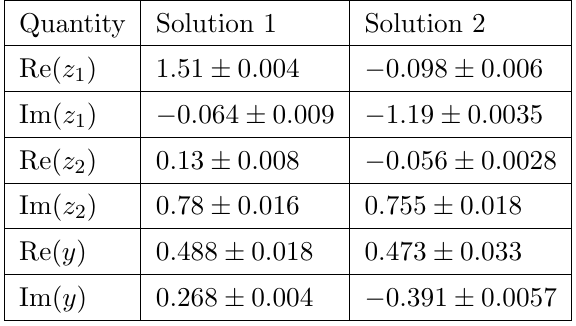
Table 2 . The values of the complex parameters z 1 , z 2 , and y for the two solutions for Case II. can be modi(cid:12)ed to allow a realistic quark sector, without a(cid:11)ecting the predictions for the lepton